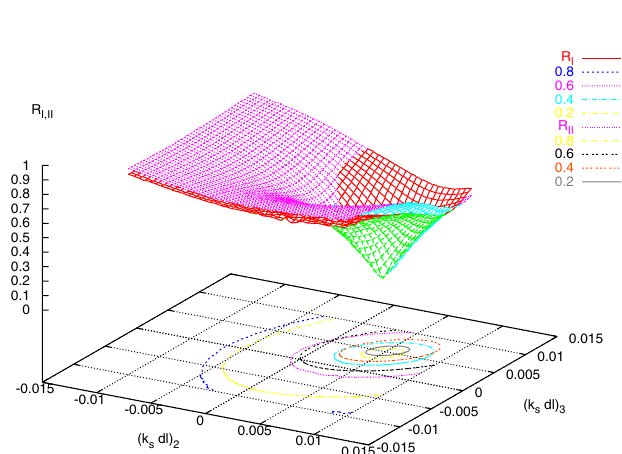
in a 2D decou- I;II